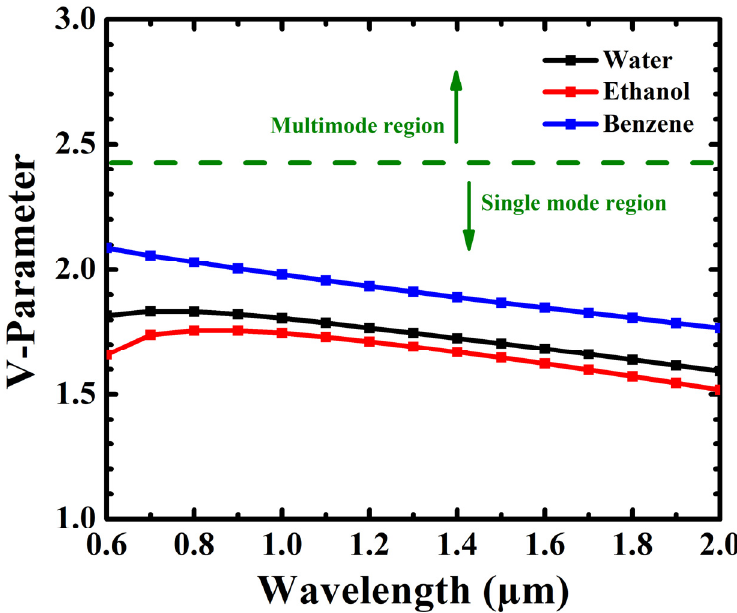
Figure 12. V-Parameter of the PCF sensor with water, ethanol and benzene, for different operating wavelengths.